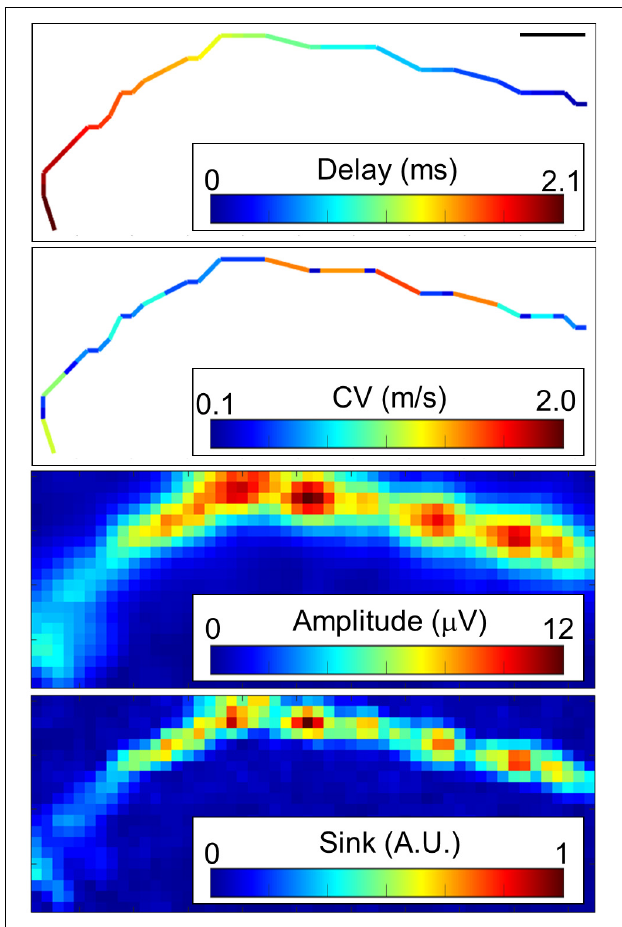
FIGURE 3 | Representative propagating signals along axons. Propagating signals in some axons show variant conduction velocity (CV). Amplitude and electrical sink calculated with current source density analysis also show variation along the axon. Note that the CV was inclined to be lower in the locations displaying higher amplitudes and electrical sink. The scale bar indicates 100 µ m. More than 20 spikes were averaged at each electrode. Electrical recording at 61 DIV.